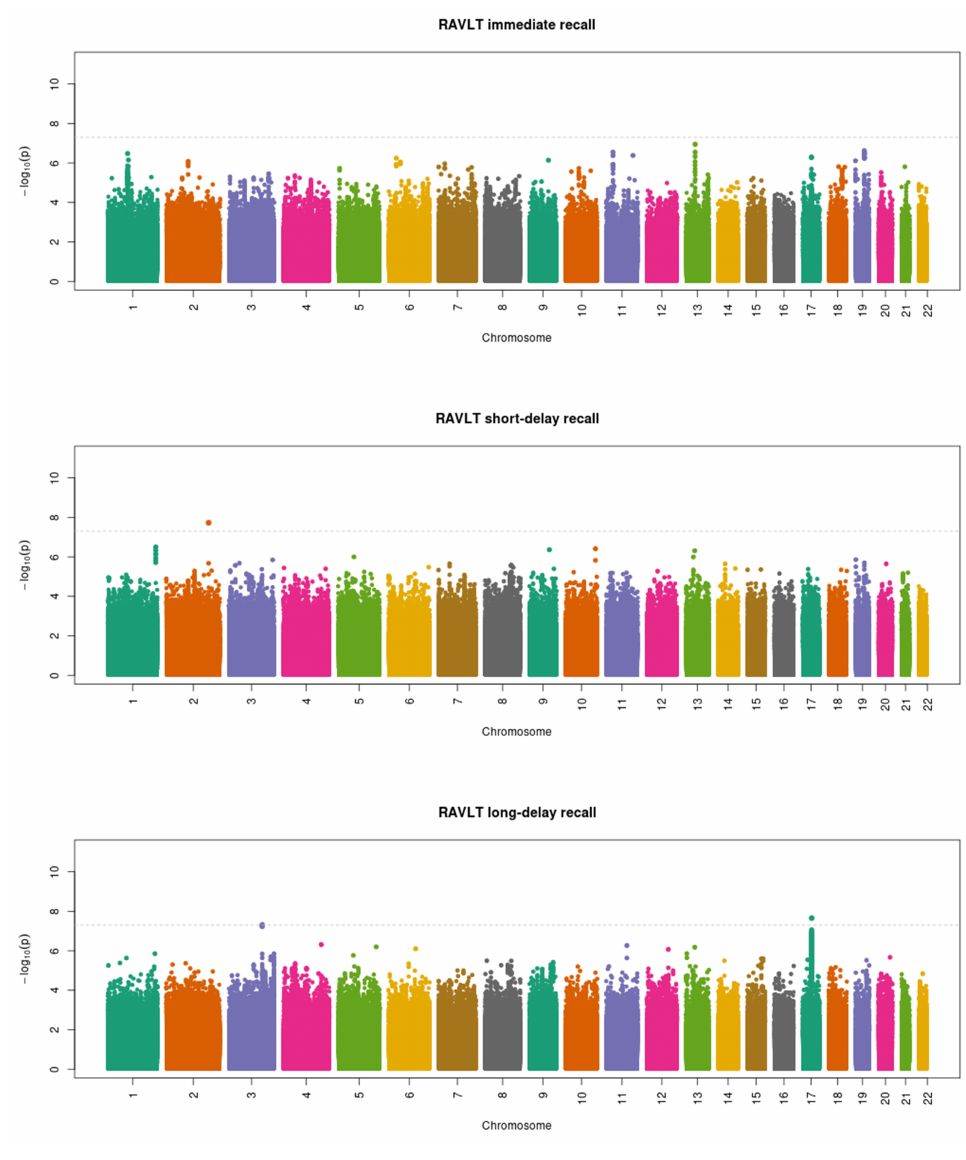
Figure 1. Manhattan plots of the genome-wide association analysis of the three verbal memory traits in the whole sample. The dotted line indicates the genome-wide significance threshold of p = 5 × 10 − 8 . RAVLT, Rey Auditory Verbal Learning